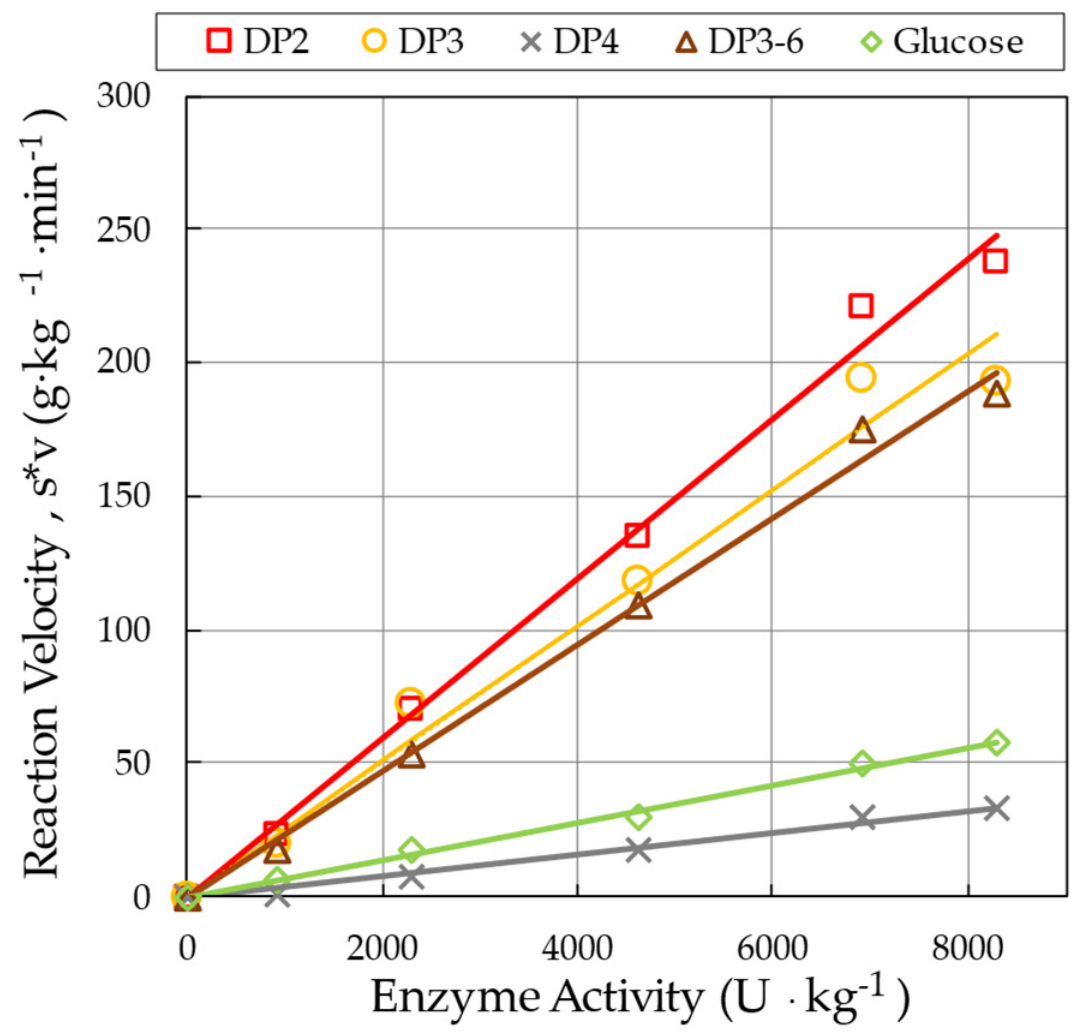
Figure 3. No-intercept linear relationship between enzyme activity and initial reaction velocity (p_1 × p_2) of various saccharide fractions. Table 3. The slopes of the no-intercept linear regression functions fitted to the reaction velocity (Y) depending on enzyme activity for different saccharides fractions. No-Intercept Saccharides Compounds R Linear Regression Slopes